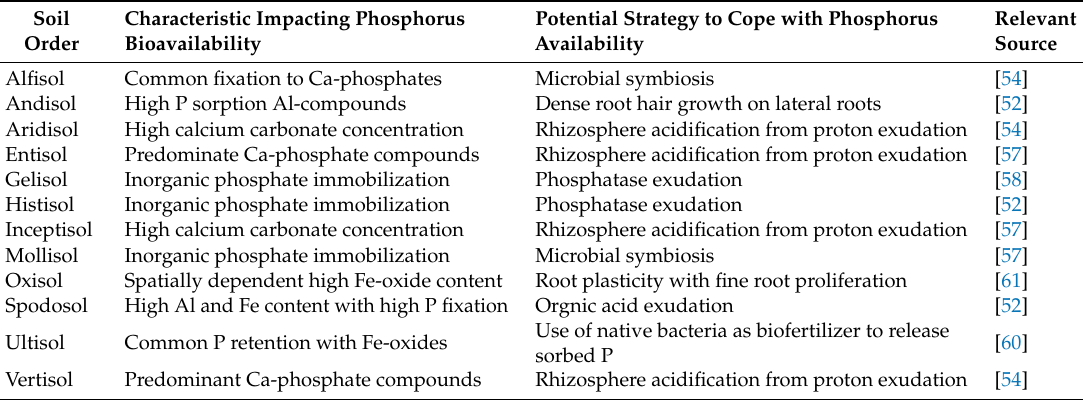
Table 2. Strategies to enhance phosphorus acquisition across di ff erent soil